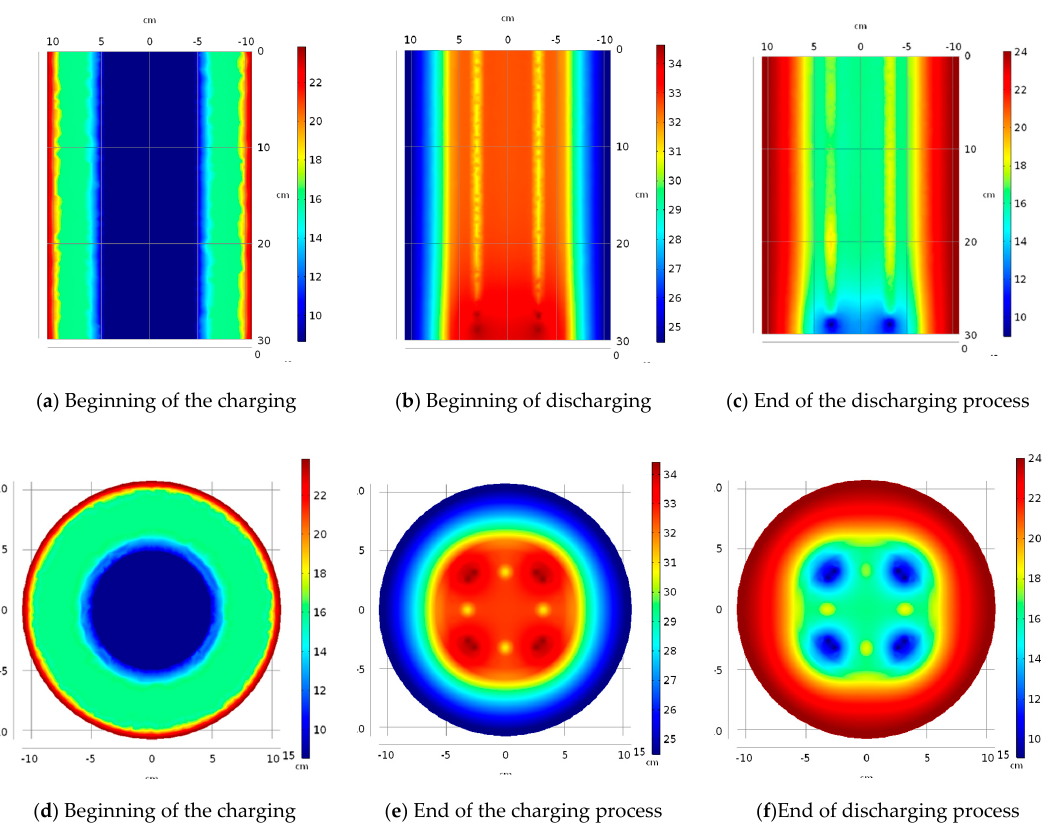
Figure 14. Thermal map at Q = 1471 mL/min.